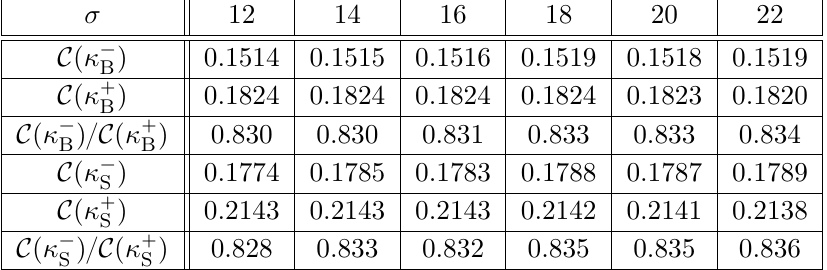
Table 2 . The values of C p κ ˘